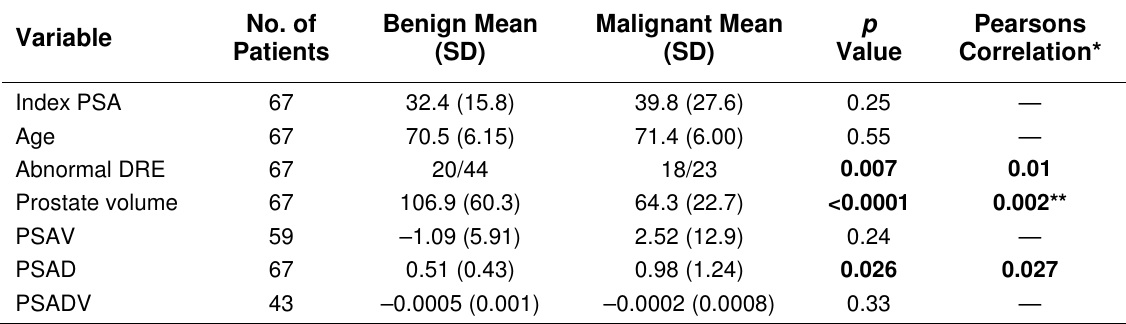
Subgroup Analysis (Comparison of Means and Correlation